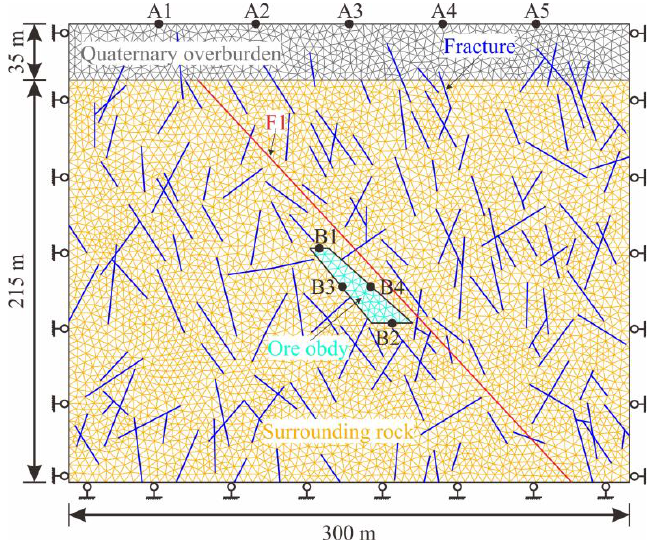
Figure 5. Numerical model. Table 1. Numerical model